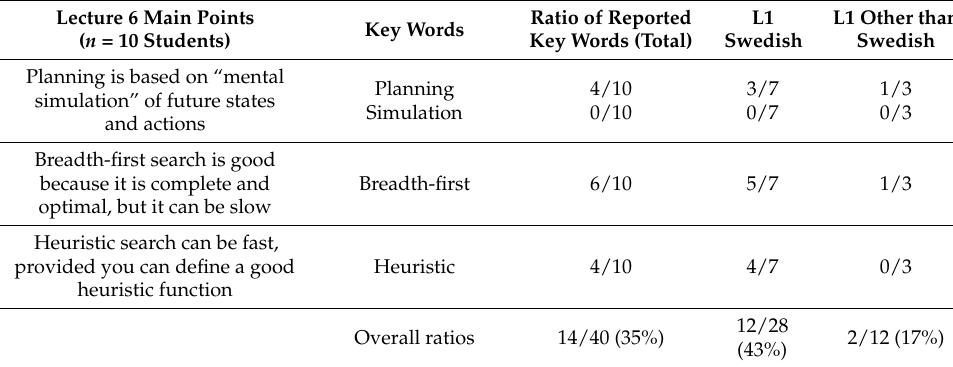
Table 7. Lecture 6 main idea key words